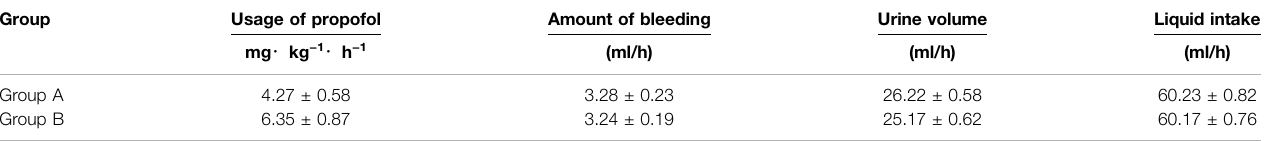
TABLE 3 | Comparison of propofol usage and fl uid in fl ow and out fl ow between the two groups (N = 40, X ± s).